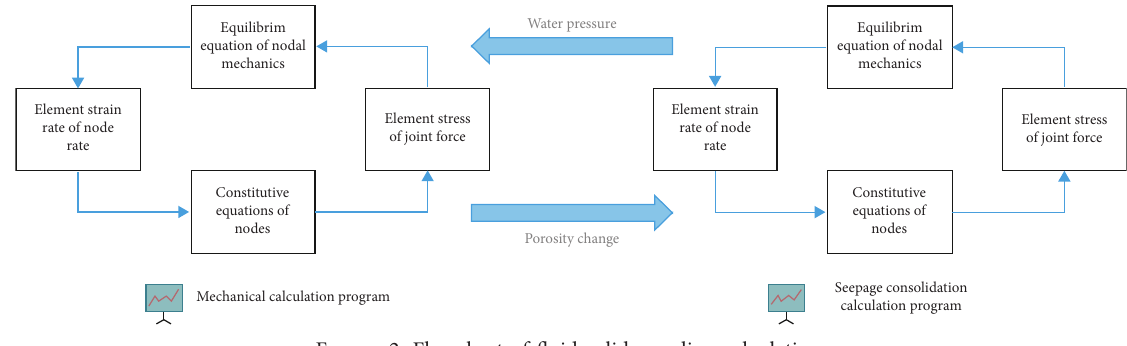
Figure 2: Flowchart of fluid-solid coupling